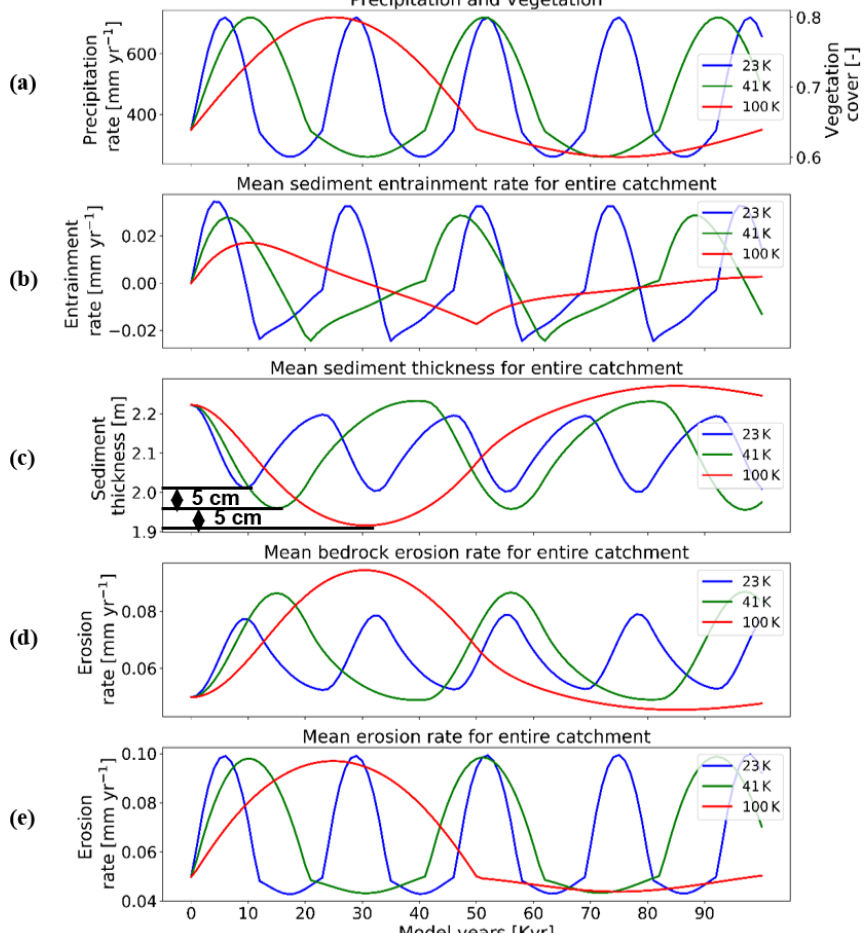
Figure 9. Temporal evolution of catchment-averaged predictions for scenario 4 described in the text (Sect. 3.4). Graphical representation of mean catchment sedimentation and erosion to (a) different periodicities of coupled oscillations in precipitation [mmyr − 1 ] and vegetation cover [–] in terms of (b) sediment entrainment [mmyr − 1 ], (c) sediment thickness [m], (d) bedrock erosion [mmyr − 1 ], and (e) mean erosion rates [mmyr − 1 ] for the entire catchment. The rate of rock uplift is kept constant at 0.5mmyr − 1 . The simulations represent 70% initial vegetation